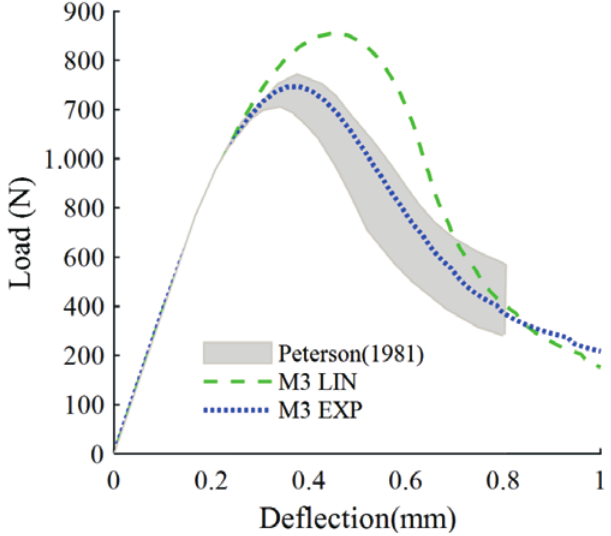
Figure 12 Load x Deflection of the beam with different mesh sizes